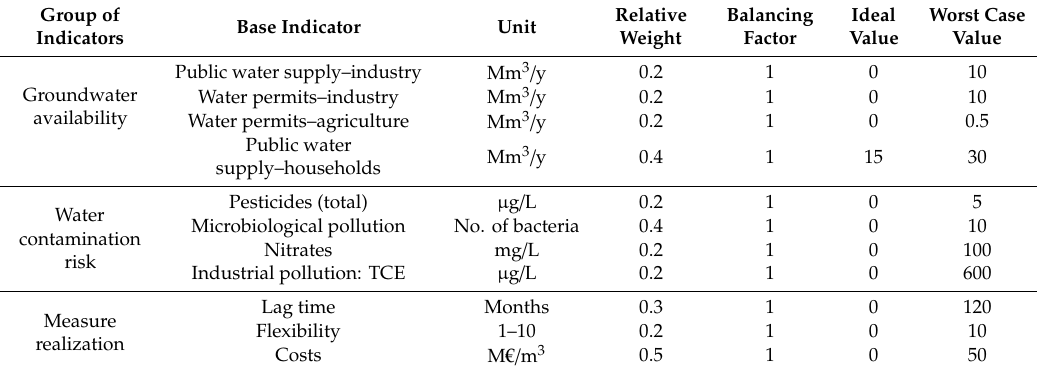
Table 2. Example of weights, balancing factors, ideal, and worst values for indicators for selected scenario